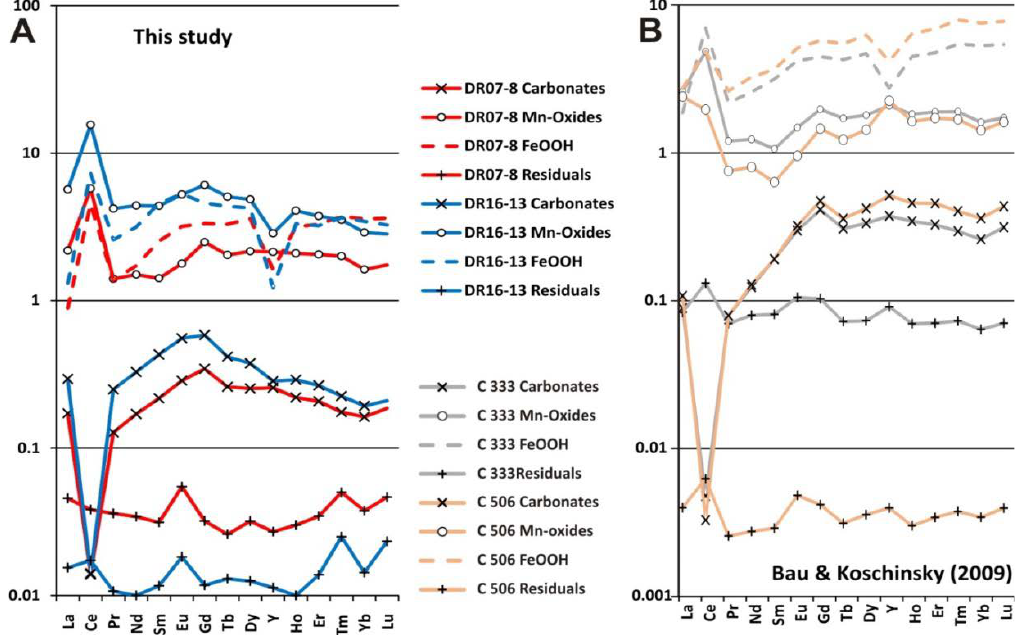
Figure 13. The four sequential leaching fractions corresponding to carbonates, Mn-oxides, Fe-oxyhydroxides and residuals obtained in both crusts normalised to PAAS [68]. Comparison ratio between ( A ) the leaching fraction of this study’s crust and [94] ( B ).